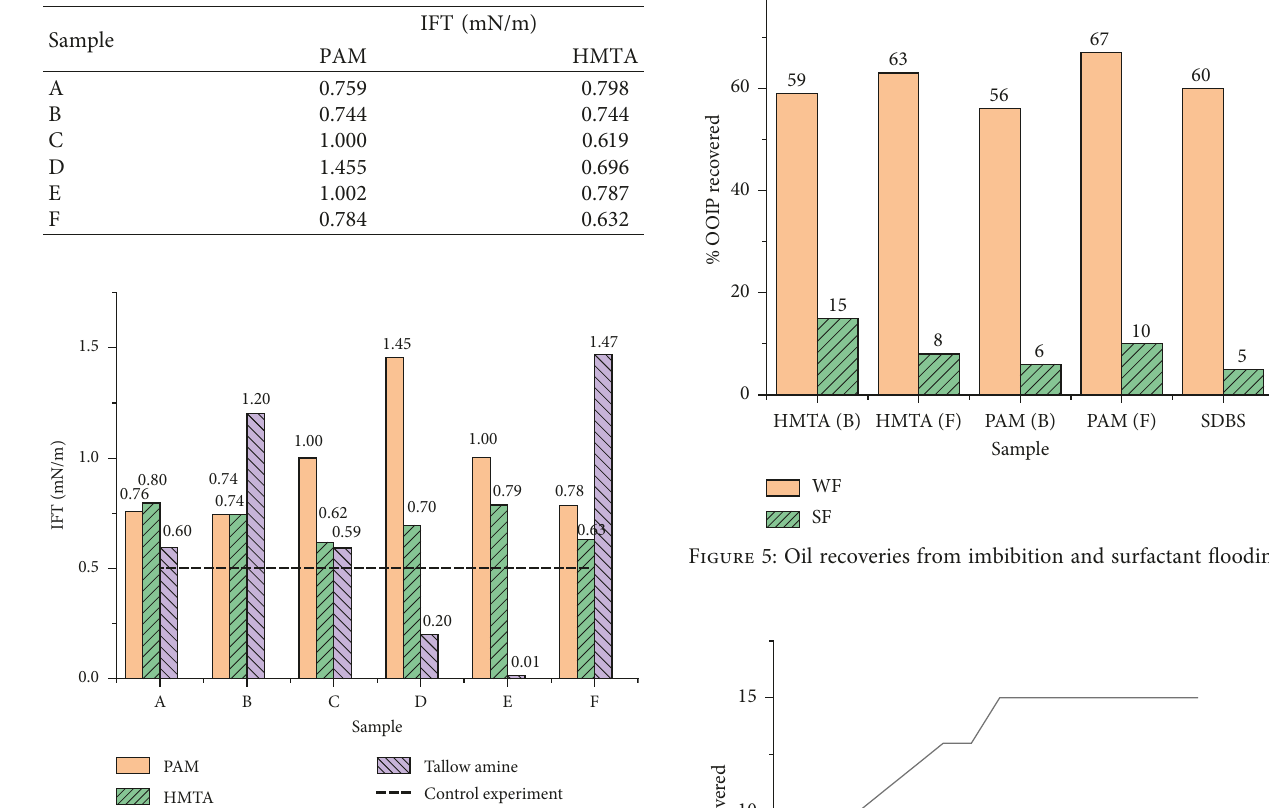
Figure 4: IFT of surfactant blends using PAM, HMTA, tallow amine, and control experiment.